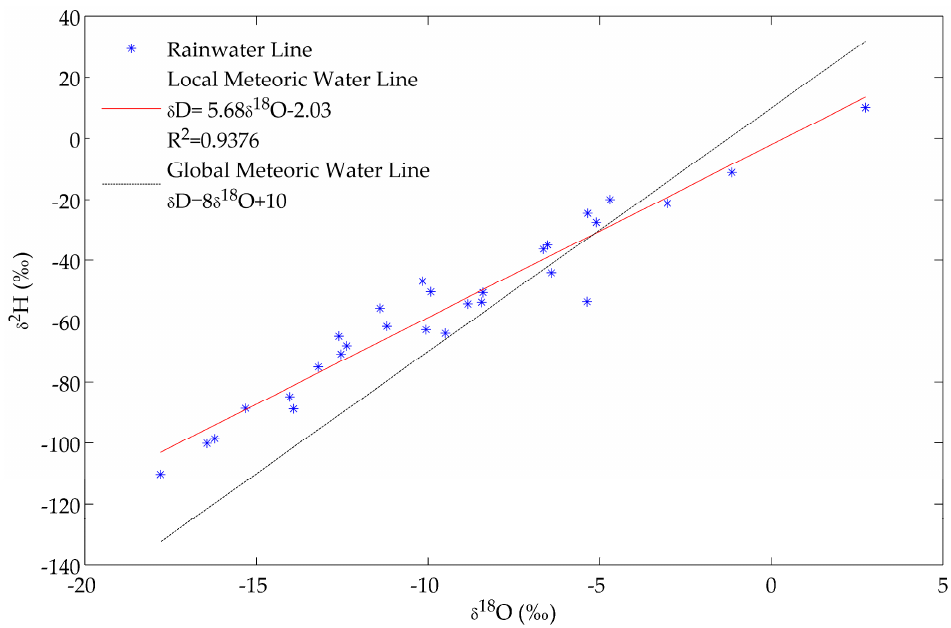
Figure 2. Plot of Local Meteoric Water Line (LMWL) for precipitation samples and the Global Meteoric Water Line (GMWL).